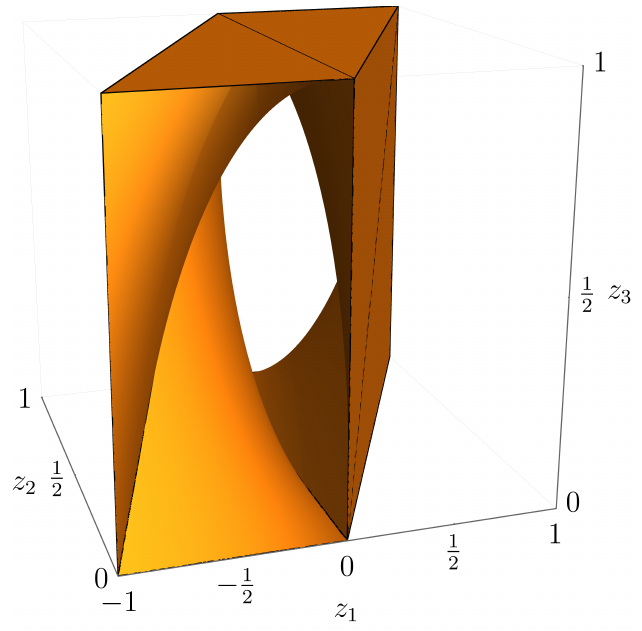
Figure 19: The four regions with Trop < 0 for the s -channel of the non-planar annulus